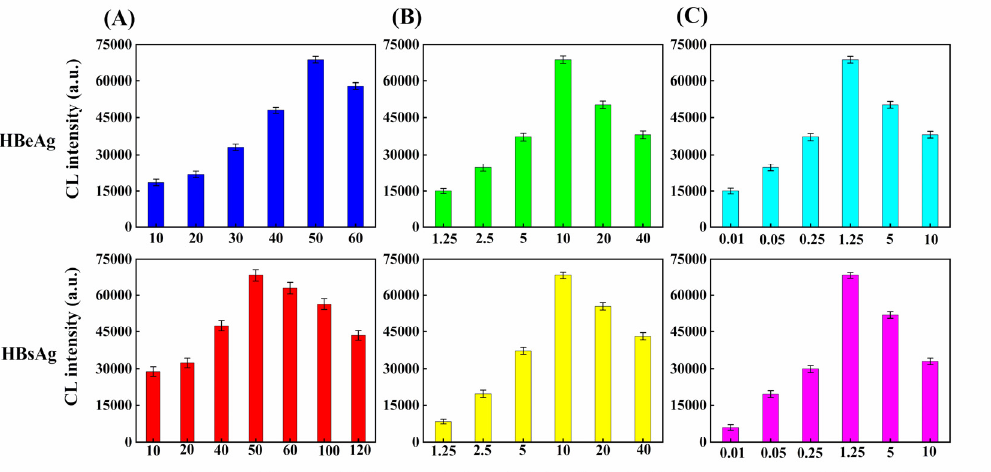
Figure 3. Effect of the immunoassay conditions on the response of the optical fiber-based sensor. ( A ) ( A ) Ab 1 concentration ( B ) Biotin-Ab 2 concentration, and ( C ) streptavidin Ab 1 concentration ( B ) Biotin-Ab 2 concentration, and ( C ) streptavidin concentration.